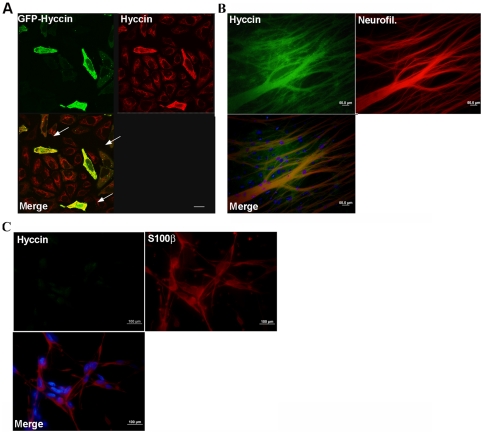
Immunofluorescence analysis of hyccin expression in DRG neurons and Schwann cell cultures.Panel A: Immunocolocalization of GFP-Hyccin transiently transfected in Hela cells and the anti-hyccin polyclonal antibody. Representative images of Hela cells transfected with GFP-Hyccin and immunostained with anti-hyccin polyclonal antibody 24 hr after transfection. Hyccin immunoreactivity was detected by Alexa546 conjugated secondary antibodies. The arrows in the merge panel show colocalization of the two signals in the cytosol. Final magnification 63×. Scale bars represent 100 µ. Panel B: DRG neurons cultures were immunostained with an anti-hyccin antibody and an anti-phosphorylated neurofilament. Hyccin and Neurofilament immunoreactivities were detected respectively by Alexa488 and Alexa546 conjugated secondary antibodies. The merge panel shows positivity of the two signals in the neurites. Final magnification 40×. Panel C: Schwann cells cultures were immunostained with an anti-hyccin polyclonal antibody and an anti-S100 monoclonal antibody. Hyccin and S100 immunoreactivities were detected respectively by Alexa488 and Alexa546 conjugated secondary antibodies. Final magnification 100×.